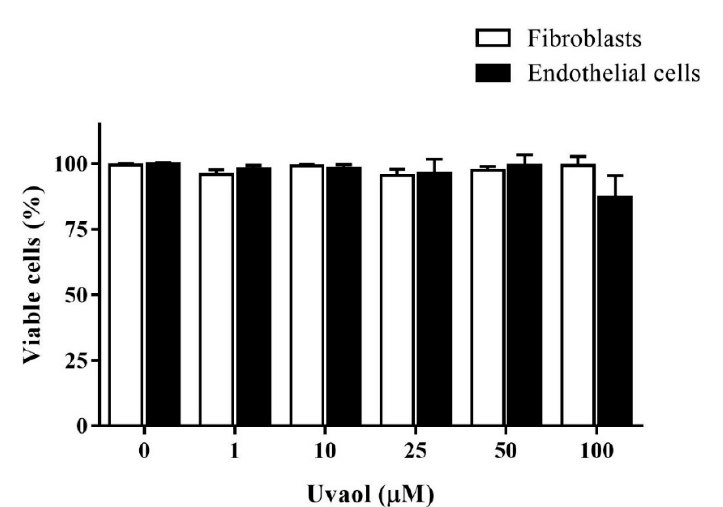
Figure 2. Effect of uvaol on the viability of fibroblast and endothelial cells. Cells were plated and treated with uvaol (1–100 µM) for 24 h. Cell viability was measured by MTT assay. The bars represent the mean ± standard deviation (SD) of three experiments performed in triplicate.